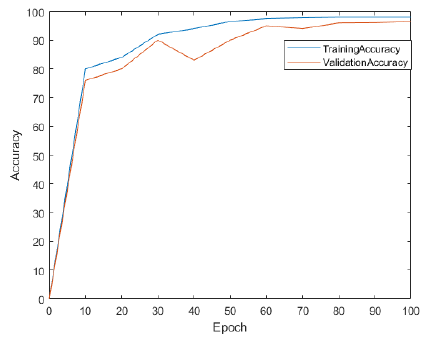
Figure 6. The effect of epoch.